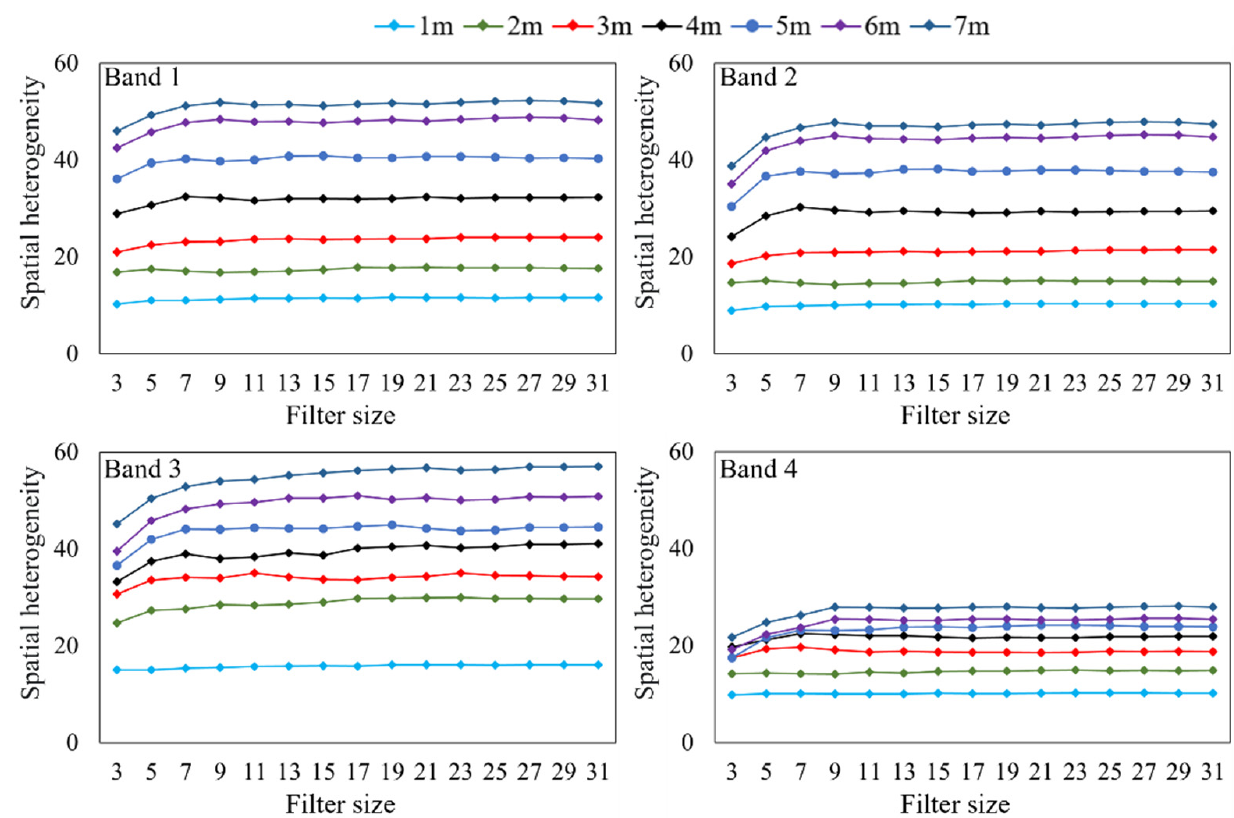
Figure 6. The SH plots varied with the window sizes of the fi lter-based method.